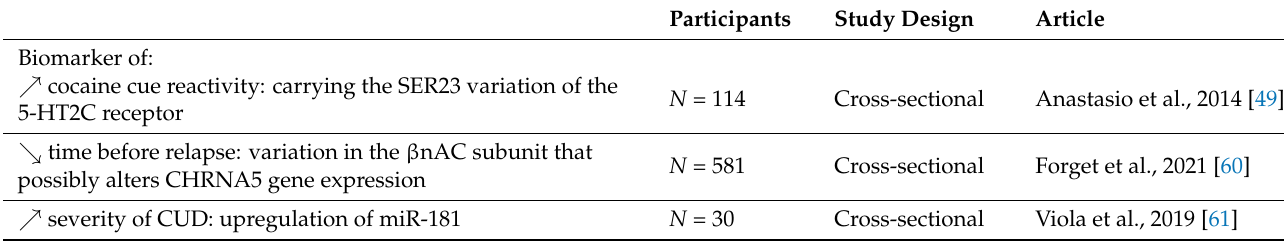
Table 4. Genetic and genomic biomarkers.